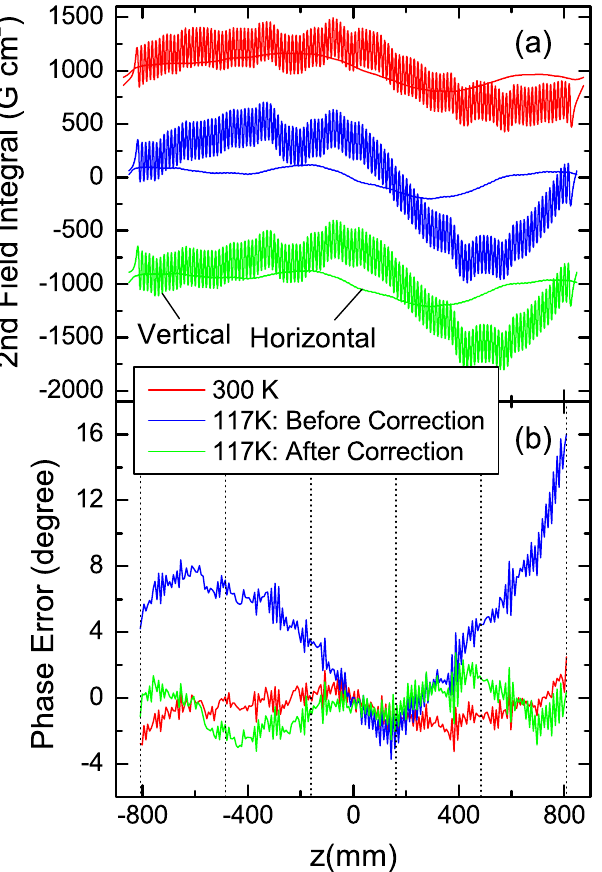
FIG. 5. (Color) Results of the field measurements in terms of (a) the beam trajectory and (b) the phase error. Dotted lines show the locations of the differential adjuster as the outer shafts. Note that the beam trajectories have been offset for readability.